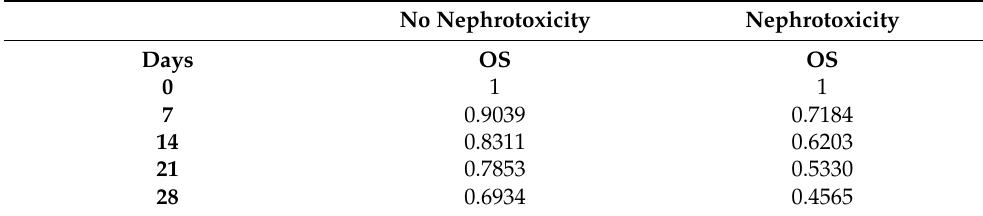
Figure 3. Kaplan–Meier estimate of survival from nephrotoxicity in colistin/aminoglycoside (AG)- treated patients ( n = 194). Table 6. Log-rank test for equality of survivor functions, p -value= 0.0021.